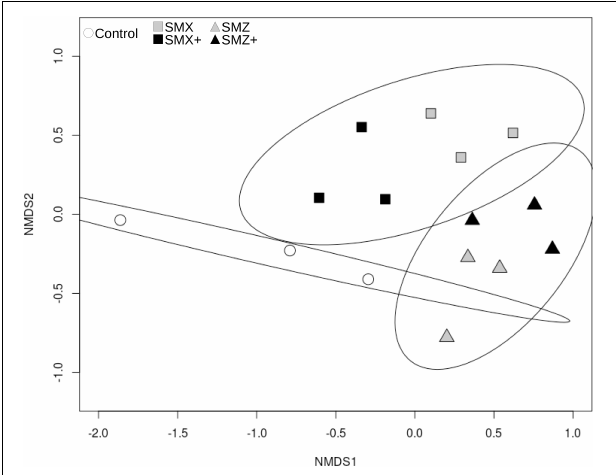
FIGURE 1 | nMDS representation of Bray-Curtis distance similarities between bacterial communities based on ARISA after 28 days of exposure to sulfonamides (sulfamethoxazole, SMX; sulfamethazine, SMZ). The stress value is 0.143. Controls are represented by white circles, communities exposed to SMX by squares and to SMZ by triangles. The level of exposure to sulfonamides is color-coded as follows: gray for exposure to 500 ng L − 1 and black for exposure to 5,000 ng L − 1 . Ellipses correspond to the 95% confidence interval around the centroid of the following groups: control, exposed to SMX (including SMX and SMX+), exposed to SMZ (including SMZ and